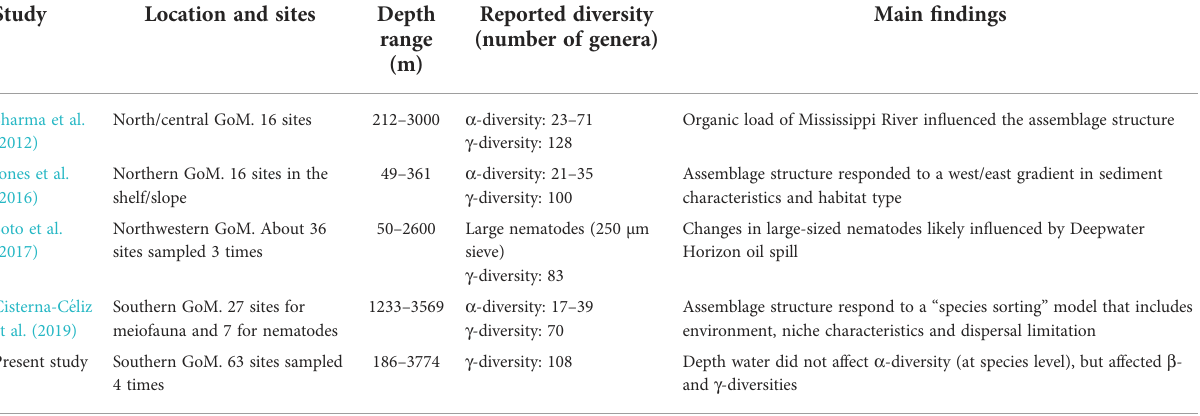
TABLE 2 Studies (in chronological order) of free-living nematode diversity in continental and deep waters of the Gulf of Mexico (GoM).